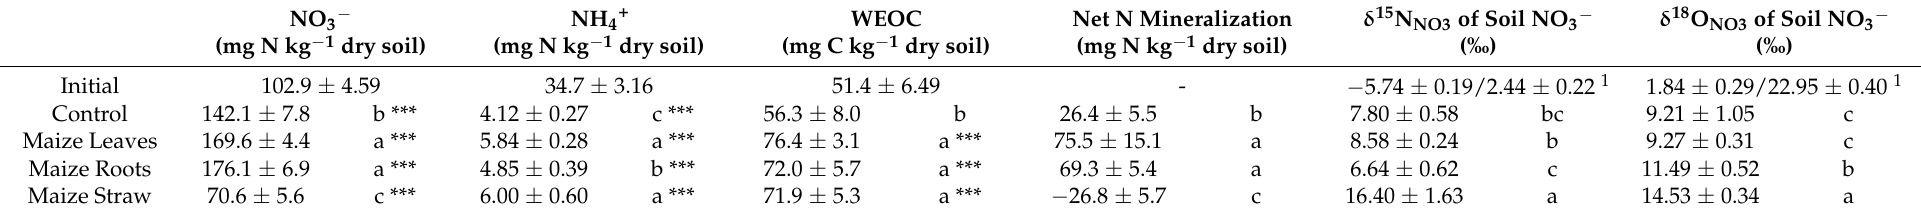
Table 2. Soil mineral N and water-extractable organic C (WEOC) before setup (initial) and at the end of the incubation experiment. Net N mineralization over the whole incubation period of 55 days.